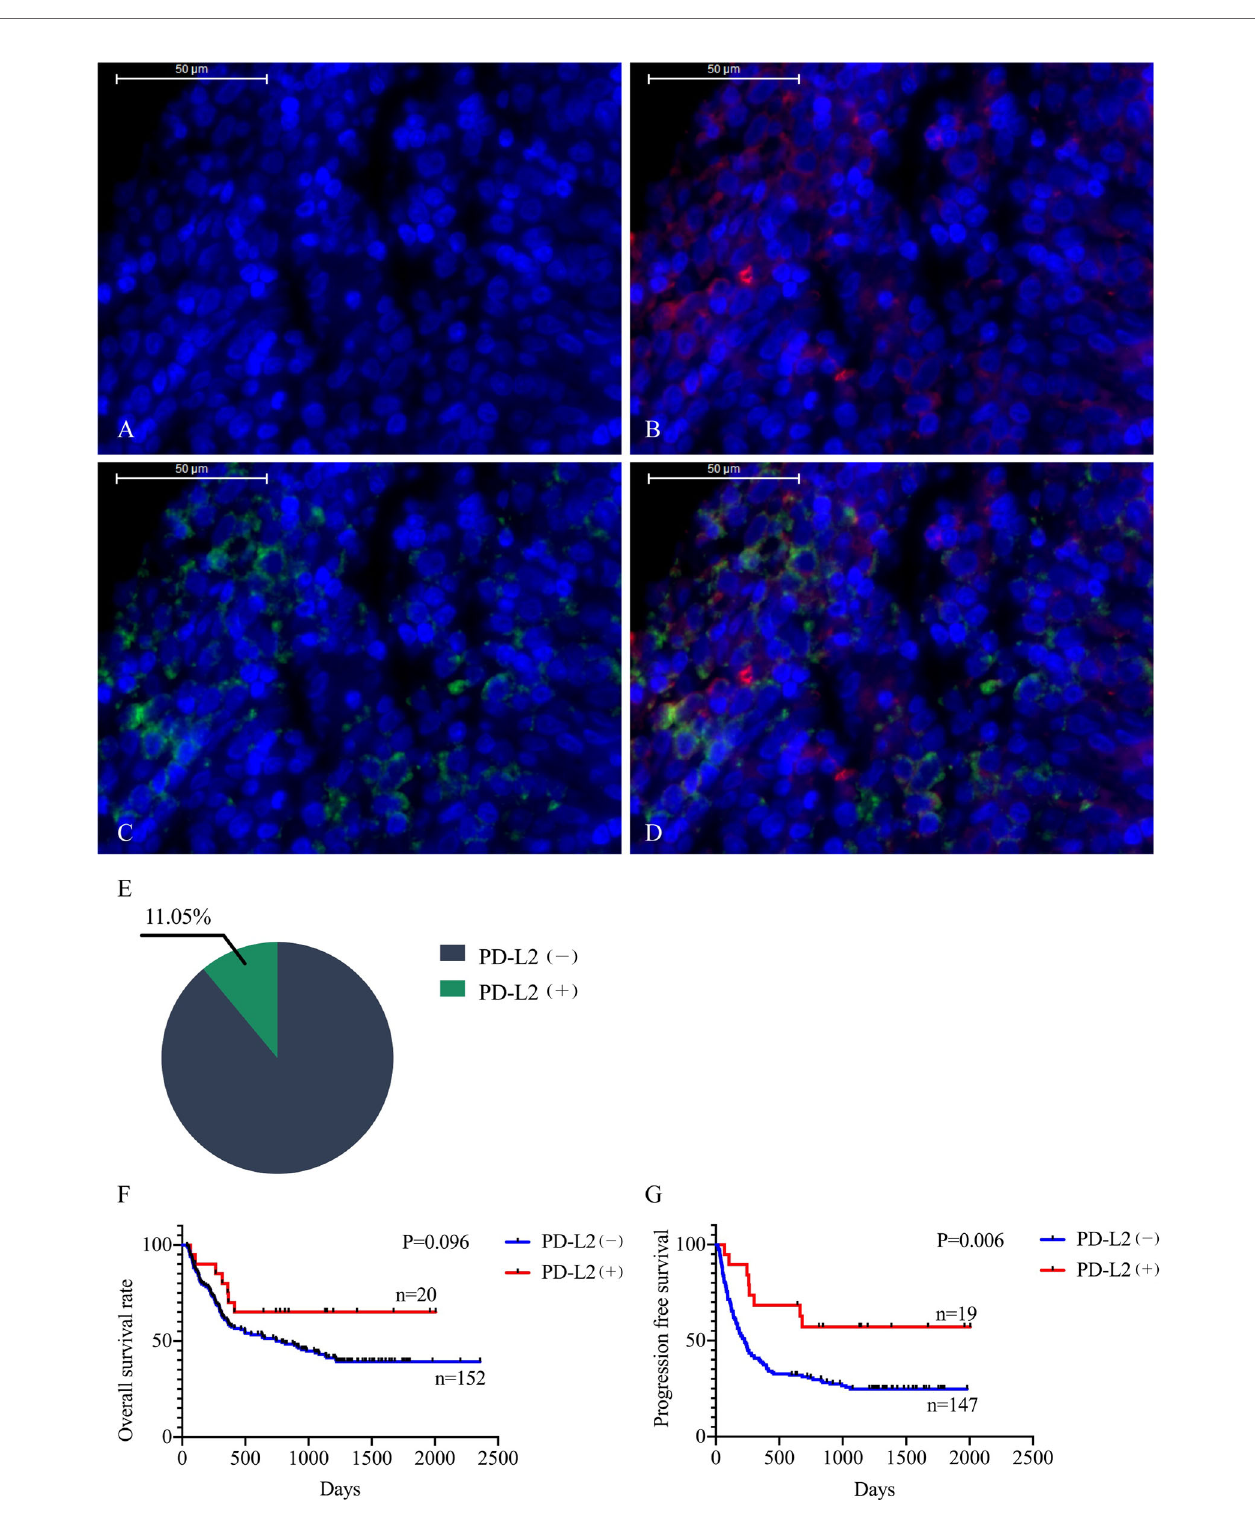
FIGURE 5 | Representative photomicrographs of multiplex immuno fl uorescence. DAPI: nuclear staining (A) , CD68 staining (B) , PD-L2 staining (C) , Merge (CD68: red signal; PD-L2: green signal) (D) . The positive rate of PD-L2 in macrophages (E) . Relationship between macrophage PD-L2 (+) and overall survival (F) and progression free survival (G) curves in newly diagnosed diffuse large B-cell lymphoma.